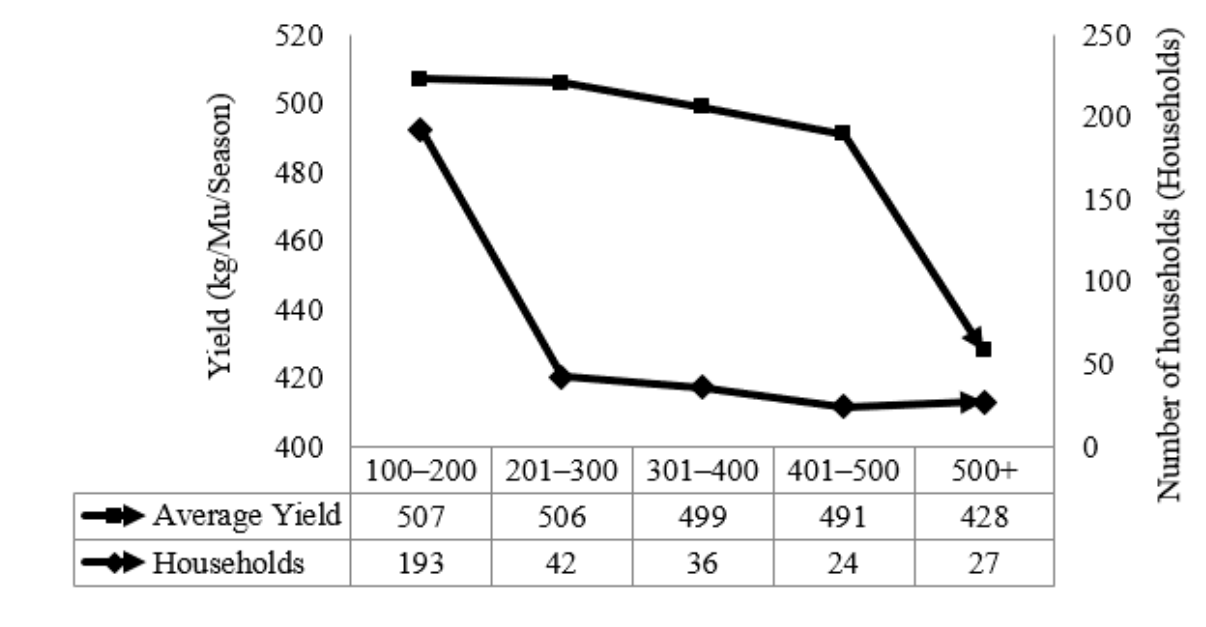
Figure 1. Scale of cultivation and production by large-scale farmers.